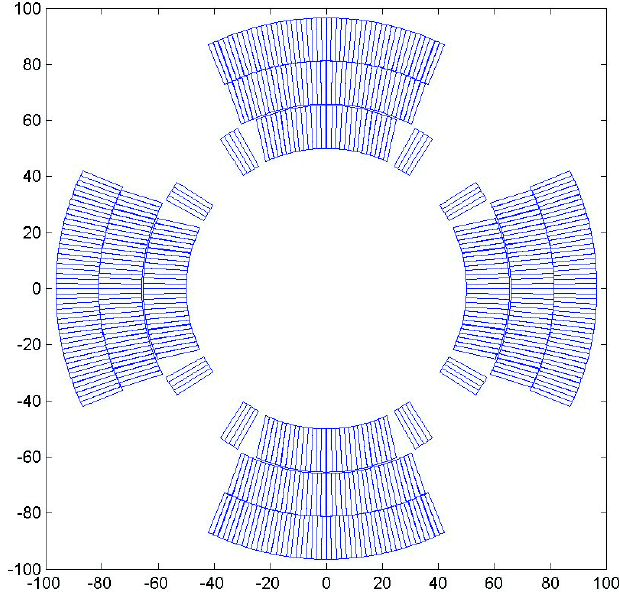
FIG. 6. (Color) Coil layout of a quadrupole with 100 mm aper- ture.